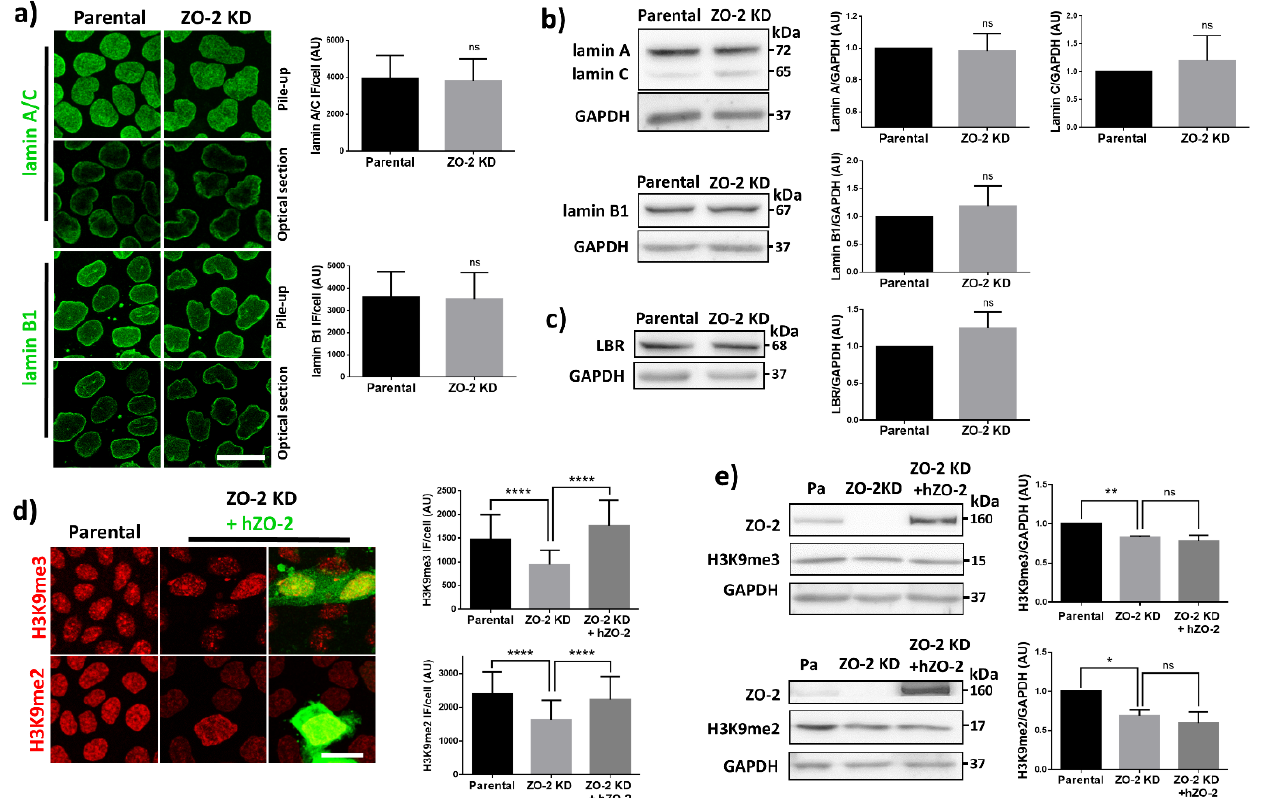
Figure 4. In ZO-2 KD MDCK cells, lamins A/C and B1 and lamin B receptors are unaffected, while the expression of constitutive and facultative heterochromatin diminishes. ( a ) Monolayers of parental and ZO-2 KD MDCK cells were processed for immunofluorescence with antibodies against lamins A/C and B1. Left panels, representative images obtained of pile-ups or single sections; bar, 20 μ m. Right, quantitative analysis was done with ImageJ of pile-up images. Data obtained with 200 nuclei in parental condition and 141 nuclei in ZO-2 KD condition for lamin A/C, and 380 nuclei per experimental condition for lamin B1, from two independent experiments. Statistical analysis was done with Mann–Whitney test. Results are shown as media ± standard deviation. ns, non-significant. ( b ) Western blot analysis of lamins A/C and B1 in parental and ZO-2 KD MDCK cells. GAPDH was employed as a loading control. Left, representative images; right quantitative analysis. Results from three independent experiments. Statistical analysis was done with Student’s t -test. Results are shown as media ± standard deviation. ns, non-significant. ( c ) Western blot analysis of lamin B receptor (LBR) in parental and ZO-2 KD MDCK cells. GAPDH was employed as a loading control. Left, representative images; right quan- titative analysis. Results from three independent experiments. Statistical analysis done with Student’s t -test. Results are shown as media ± standard deviation. ns, non-significant. ( d ) Immunofluorescence analysis of constitutive HC marker H3K9me3 and facultative HC marker H3K9me2 in parental and ZO-2 KD MDCK cells transfected or not with hZO-2. Left, representative images; bar, 20 μ m. Right, quantitative analysis was done with ImageJ. Data obtained from at least 60 cells per condition: parental cells, MDCK ZO-2 KD cells highly expressing transfected hZO-2, and ZO-2 KD cells without visible transfected hZO-2 signal. Statistical analysis was done with Kruskal-Wallis followed by Dunn’s multiple comparisons test. **** p < 0.0001. Results are shown as media ± standard deviation. ( e ) Western blot analysis of H3K9me3 and H3K9me2 in parental and ZO-2 KD MDCK cells transfected or not with hZO-2. GAPDH was employed as a loading control. Repre- sentative Western blots are shown together with the quantitative analysis. Results from three independent experiments. Statistical analysis done with One-way ANOVA followed by Tukey’s multiple comparisons test. Results are shown as media ± standard deviation. * p < 0.05; ** p < 0.01; ns, non-significant.